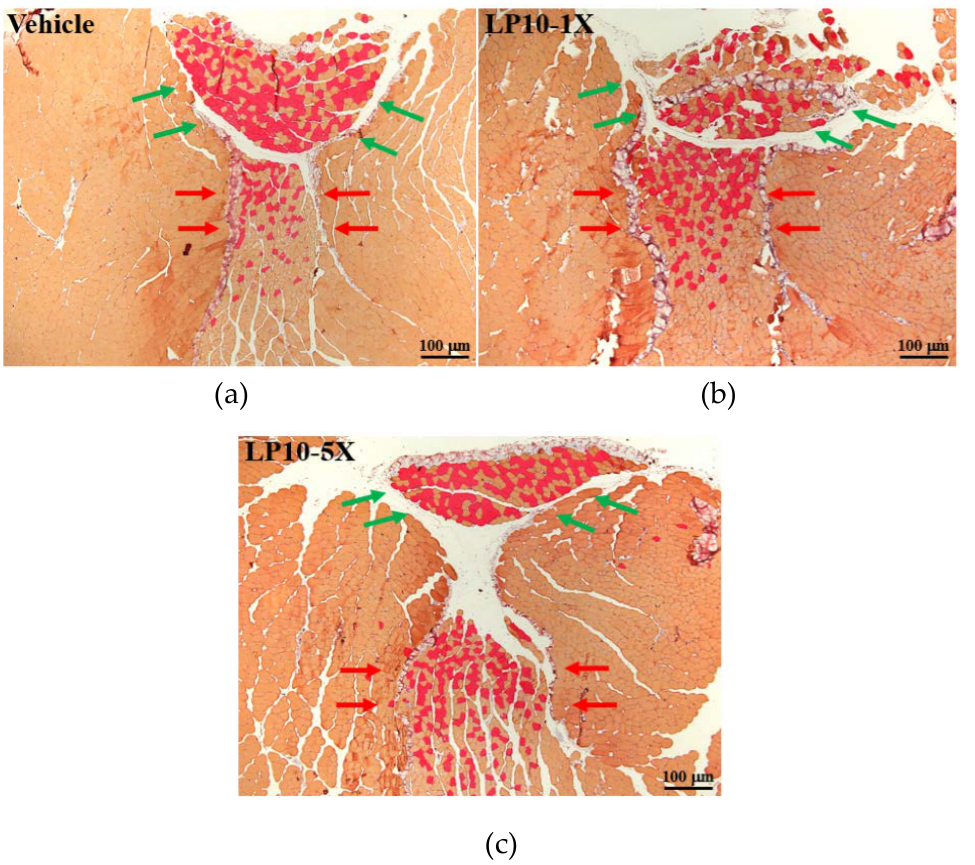
Figure 6. Immunohistochemistry (IHC) of effect of LP10 supplementation with: vehicle ( a ); LP10-1X ( b ); and LP10-5X ( c ) on type I and type II muscle fibers in gastrocnemius muscle. Red fibers are type I fibers; orange fibers are type II fibers. Specimens were photographed by light microscopy. (IHC stain, magnification: ˆ 50). Nutrients 2016 , 8 , 205